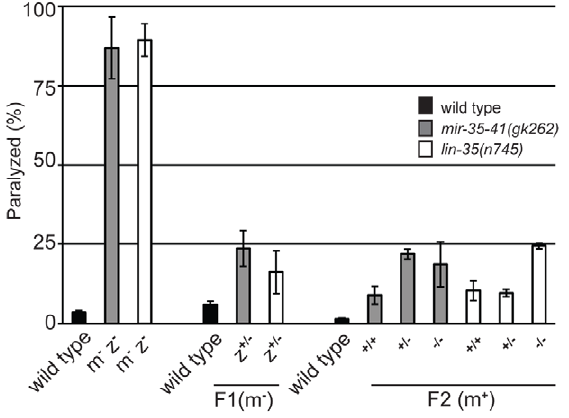
Figure 5. Maternal rescue of RNAi hypersensitivity in mir-35-41 and lin-35/Rb mutants. Histogram representing the percent of paralyzed worms for the indicated strains fed unc-22 dsRNA for 28 hours from the L4 to adult stage. Wild type and the mutants mir-35- 41(gk262) and lin-35(n745) (maternal 2 , zygotic 2 : m 2 /z 2 ) were crossed to wild type males containing a GFP expressing transgene to generate green heterozygous F1 progeny (m 2 /z + ), which were transferred to unc- 22 RNAi and scored for paralysis. To test for maternal rescue of RNAi sensitivity, heterozygous F1s were singled and allowed to self fertilize. The F2 progeny were transferred to unc-22 RNAi and each worm was scored for paralysis and then genotyped. Error bars represent the standard error of the mean (s.e.m) for two independent